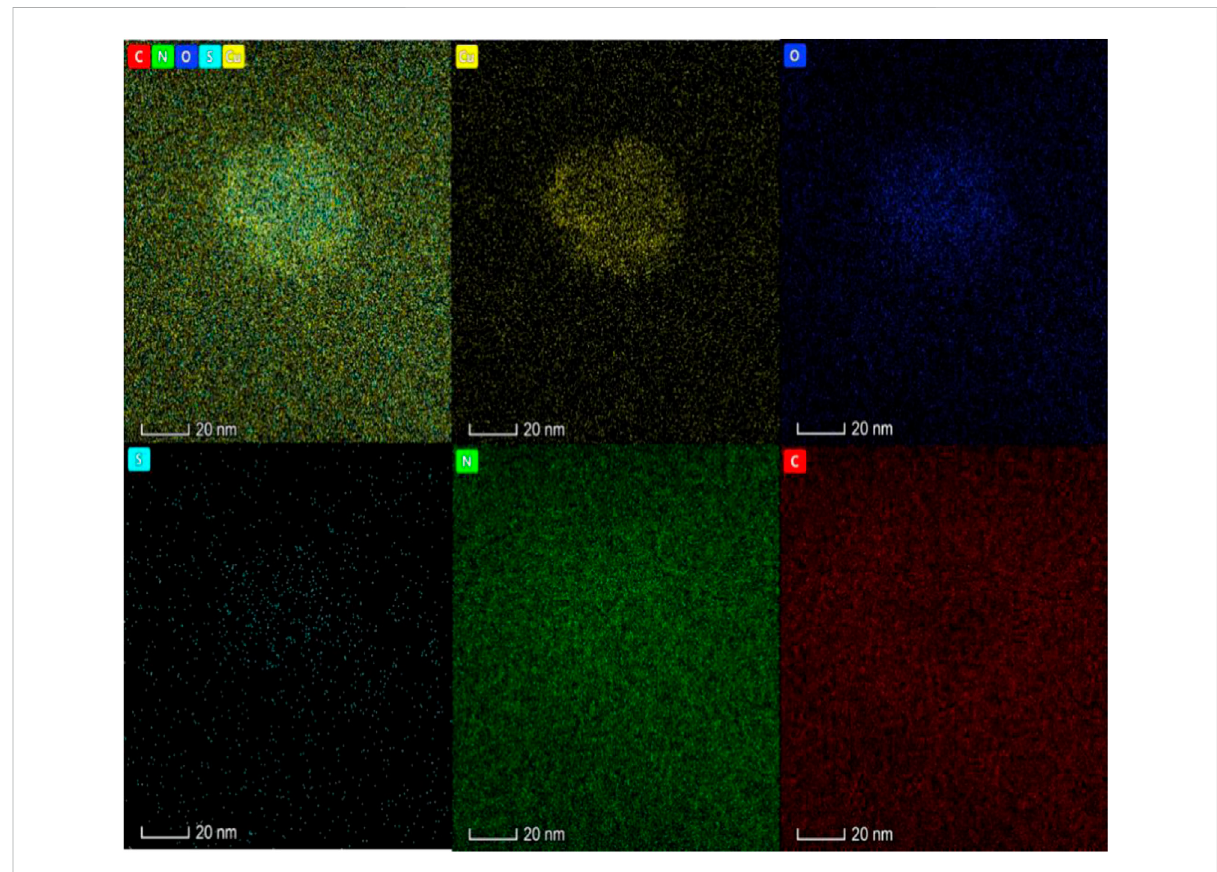
The Energy dispersive spectra of Apt-NBs@Res@Cu 5.4 ONPs shows that the material also has fi ve elements: Cu, N, O, S and C, in which Cu is mainly located in the core of the material and N is distributed in the